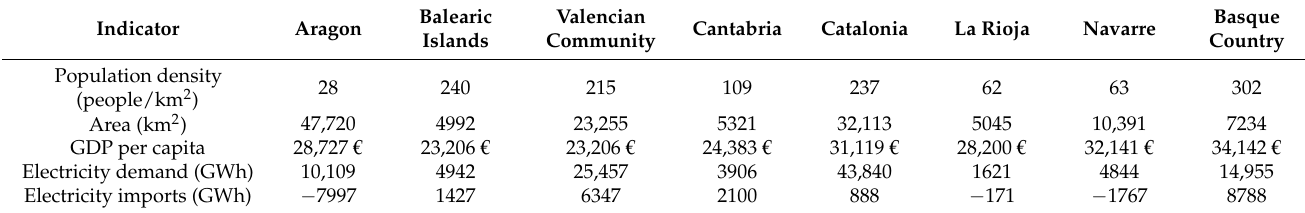
Table 1. Bioregion characteristics.